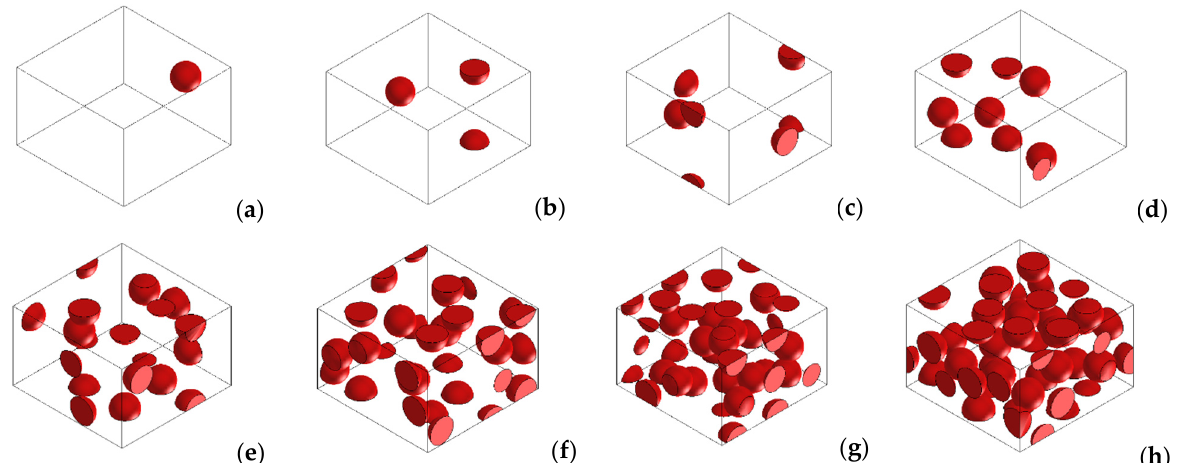
Figure 10. 3D RVEs simulated geometries for 1 KPa applied pressure as function of Cu percentages in the PU: ( a ) 0.55 vol.%, ( b ) 1.2 vol.%, ( c ) 2.6 vol.%, ( d ) 4.3 vol.%, ( e ) 6.6 vol.%, ( f ) 9.5 vol.%, ( g ) 14 vol.% and ( h ) 20 vol.%.